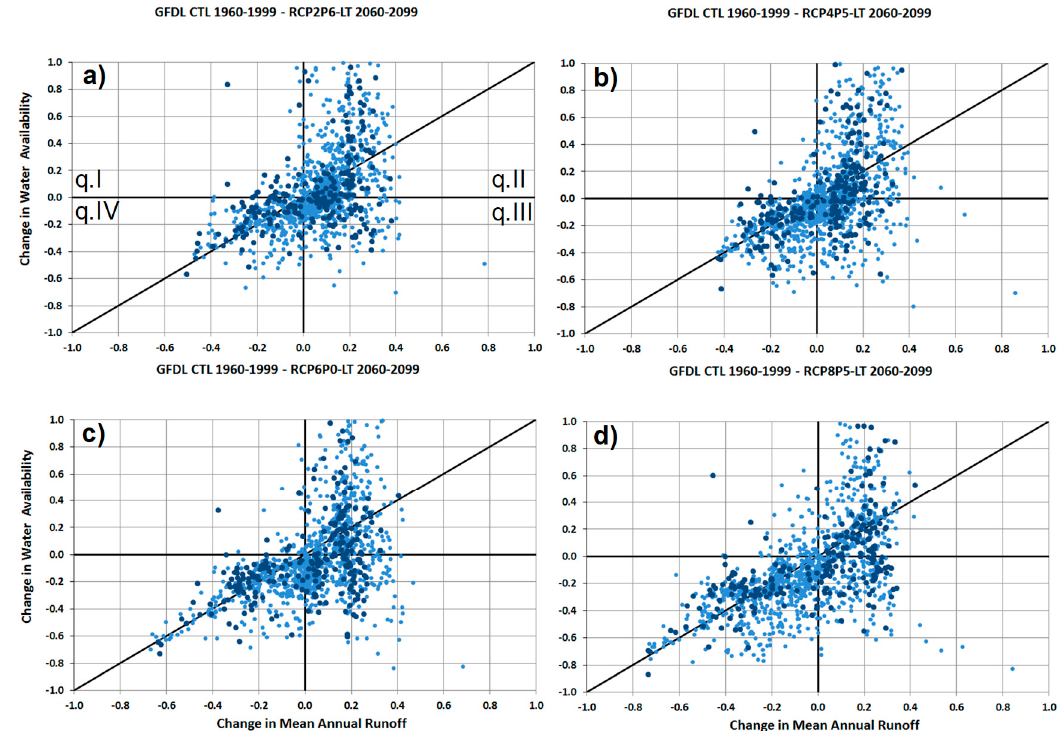
Figure 7. Changes of mean annual water availability from historical period (1960–1999) to long-term period (2060–2099) as a function of changes in runoff for model GFDL and emissions scenario RCP2.6, RCP4.5, RCP6.0, and RCP8.5. Small, blue dots represent results in intermediate sub-basins, while larger, darker blue dots represent results in the global basins. q.I, q.II, q.III, and q.IV point out each quadrant. ( a ) RCP2.6, ( b ) RCP4.5, ( c ) RCP6.0 and ( d ) RCP8.5.